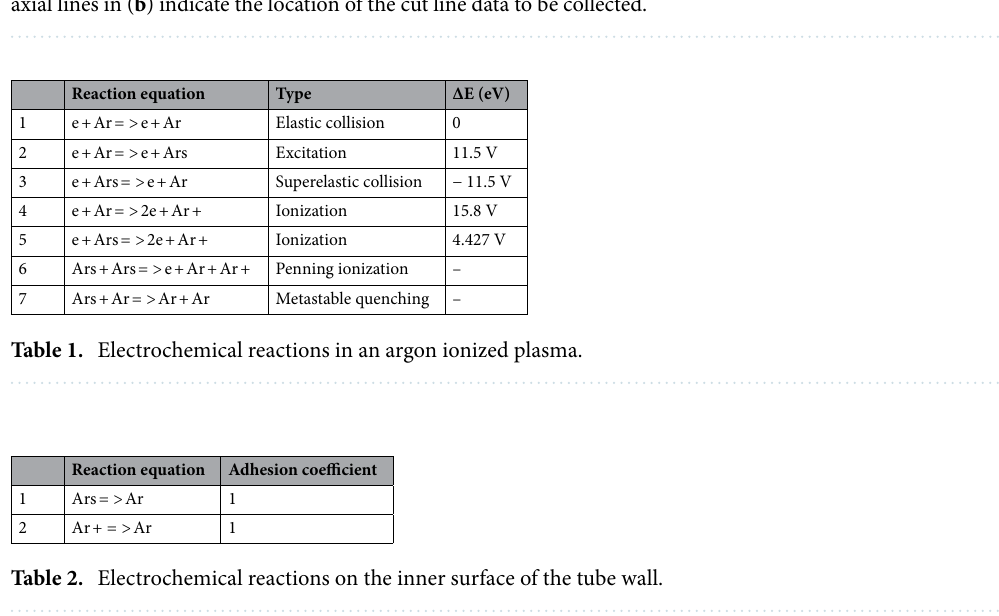
Figure 3. ( a ) ICP simulation model schematic diagram and ( b ) electron density distribution. The radial and axial lines in ( b ) indicate the location of the cut line data to be collected.